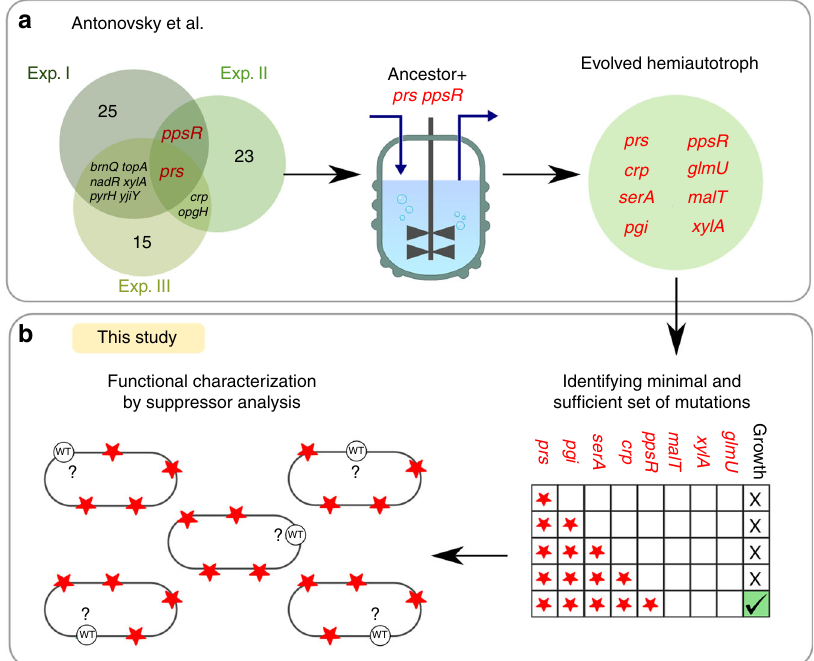
Fig. 1 Finding a compact suf fi cient set of mutations from the evolved allele pools. a Hemiautotrophic growth, in which CO 2 is fi xed for sugar synthesis, occurred independently in three chemostat evolutions (green circles, numbers indicate the number of extra mutations not written). Integration of the prs and ppsR mutations into ancestral strain and “ replaying ” evolution yielded a much more compact set of mutations (light green) (Antonovsky et al.) 3 . b The evolved alleles were combinatorially introduced to fi nd a suf fi cient set which is locally minimal, i.e., removal of any mutation from the set will cause loss of the phenotype. The reconstructed strain was evaluated and characterized by suppressor analysis to understand the functional role of each